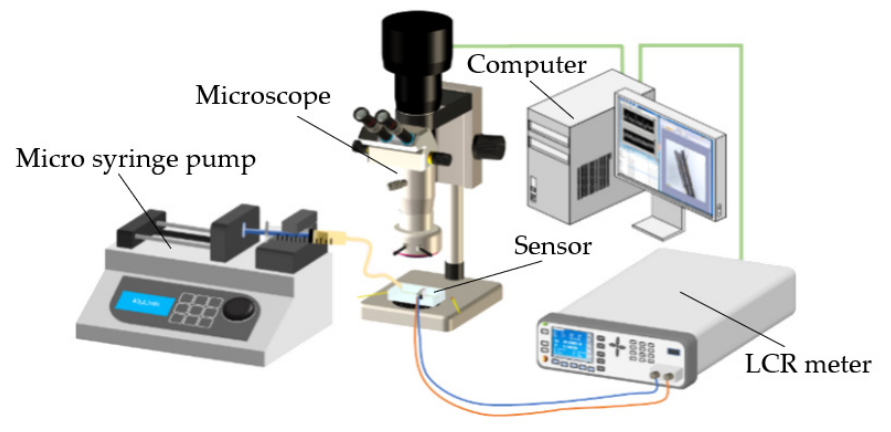
Figure 5. Experimental Systems. Before the experiment, the iron particles and copper particles of different sizes were mixed with tested hydraulic oil (The Great Wall L-HM 46, Sinopec Lubricant Co., Ltd., Beijing, China). A syringe installed on the micro-syringe pump (Harvard Apparatus B- 85259, Harvard Apparatus, Holliston, MA, USA) was filled with an appropriate amount of oil sample to be tested, then connected to inlet of the detection channel of the sensor. The speed of the micro-injection pump was set as 40 µ L/min. A computer was connected to a microscope (Nikon AZ100, Nikon, Tokyo, Japan) to observe the particles passing through the sensing area. During the experiment, the excitation voltage and frequency of the LCR meter were set as 2 V and 2 MHz, respectively. Then, the detection mode was set to inductance mode. To observe the effect of the sensor, two sensors were used to experiment. Both sensors have two 10-turns positive series planar coils, but one was wrapped with permalloy and the other without permalloy. The two sensors were used to test the oil samples containing different abrasive